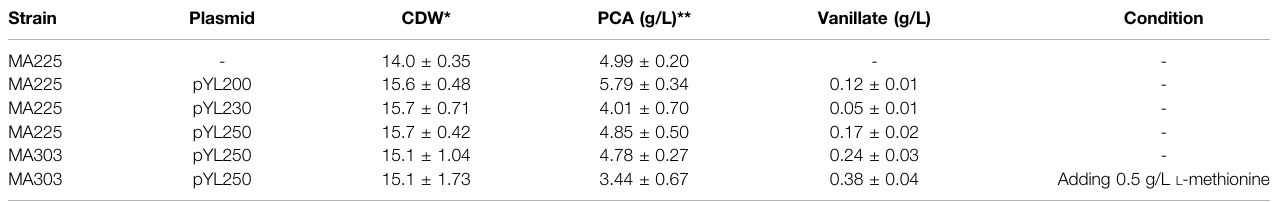
TABLE 3 | Production of vanillate using recombinant C. glutamicum strains with different plasmids for expression of the comt m gene in fl ask culture. Strain